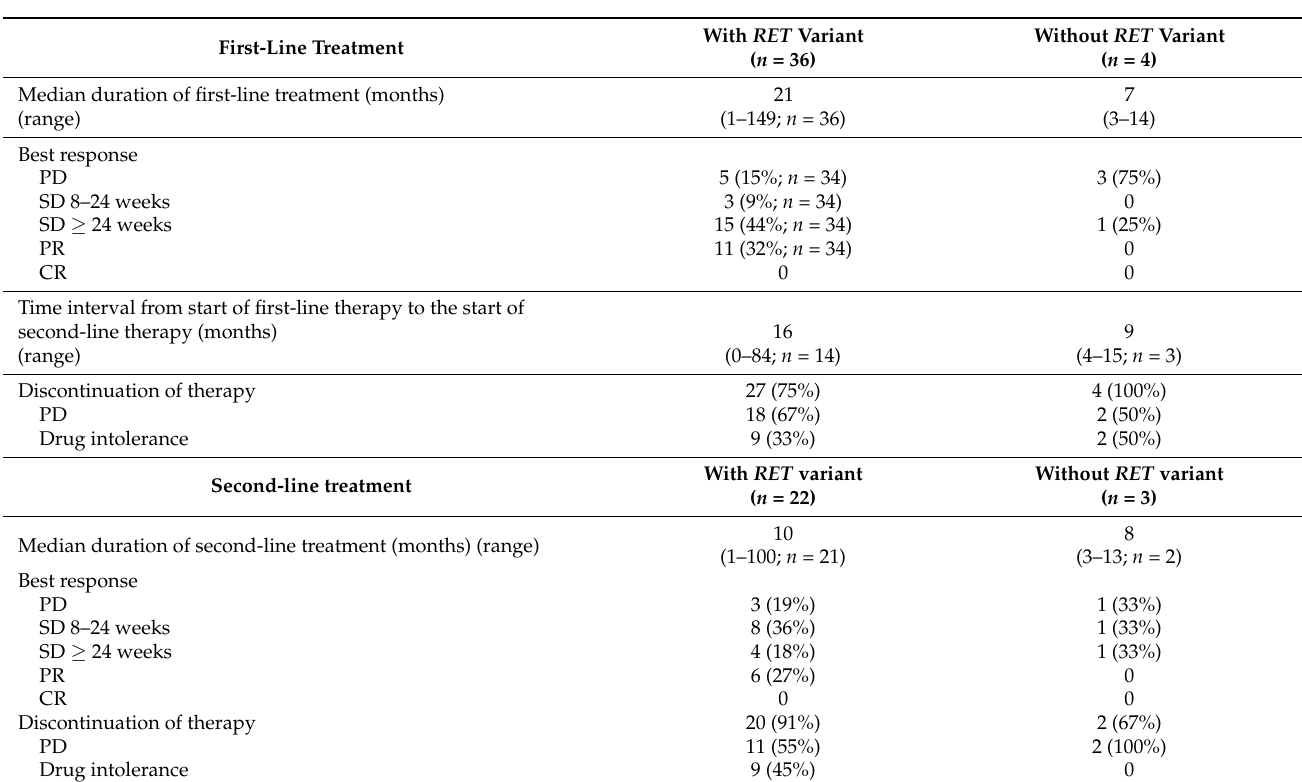
Table A3. MKI treatment response rates of first-line treatment, second-line treatment, vandetanib- treated patients and cabozantinib-treated